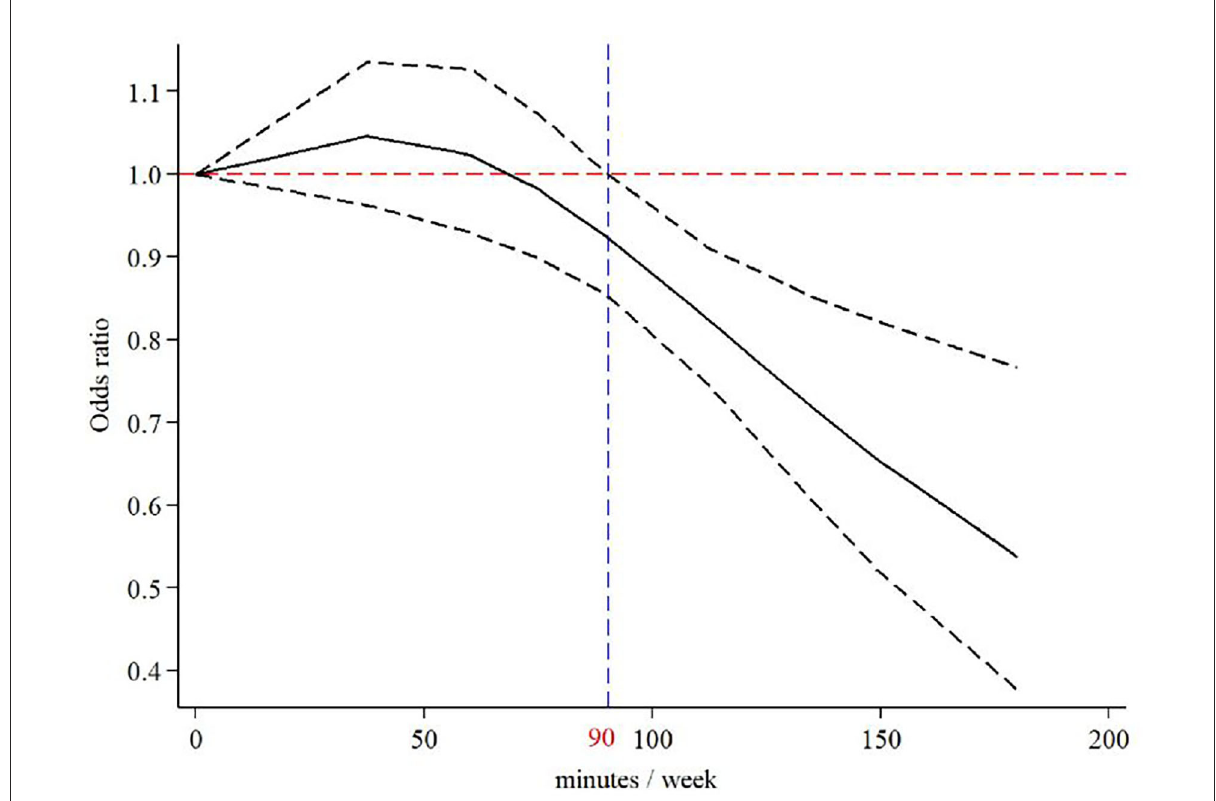
FIGURE4 The dose response analysis of physical activity duration and the risk of postpartum